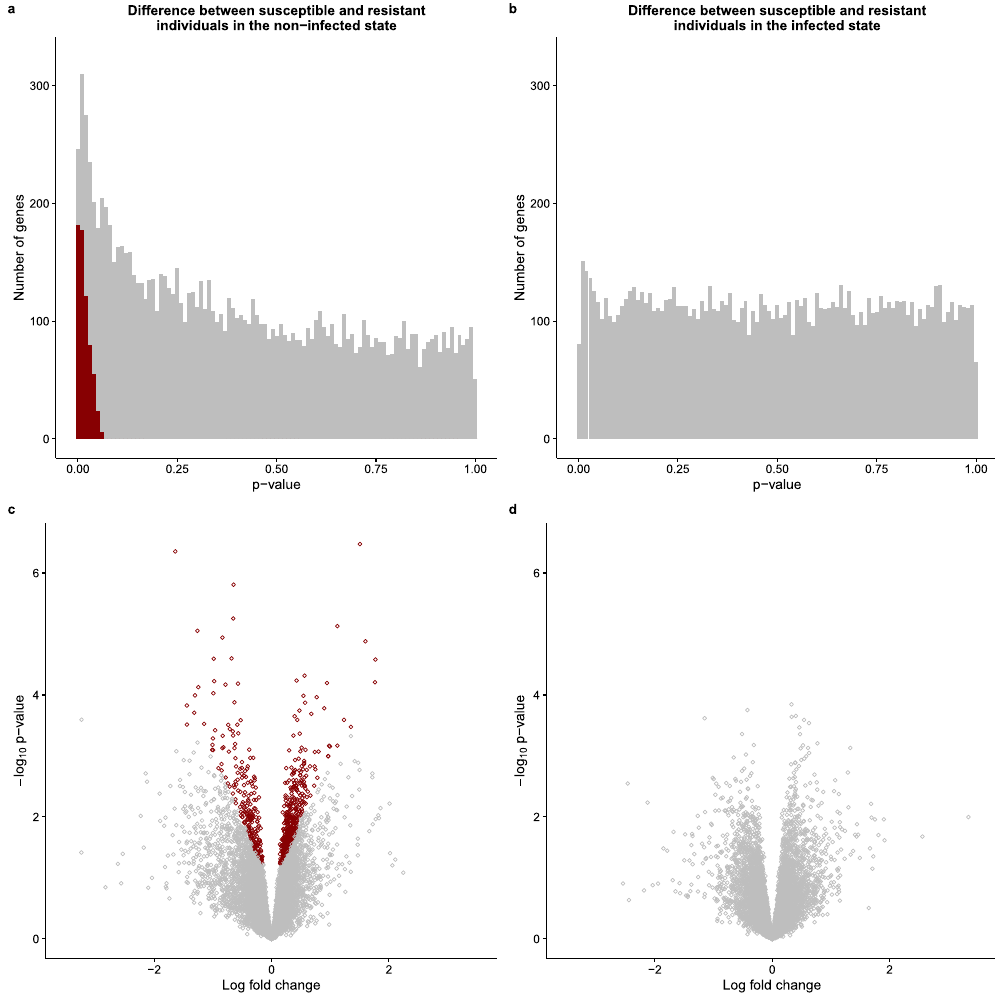
Figure 1. Results of differential expression analysis. The top panels show the distributions of unadjusted p-values for testing the null of no differential expression between susceptible and resistant individuals in the ( a ) non-infected or ( b ) infected state. The bottom panels show the corresponding volcano plots for the ( c ) non-infected and ( d ) infected states. The x-axis is the log fold change in gene expression level between susceptible and resistant individuals and the y-axis is the − log 10 p-value. Red indicates genes that are classified as differentially expressed with a q-value less than